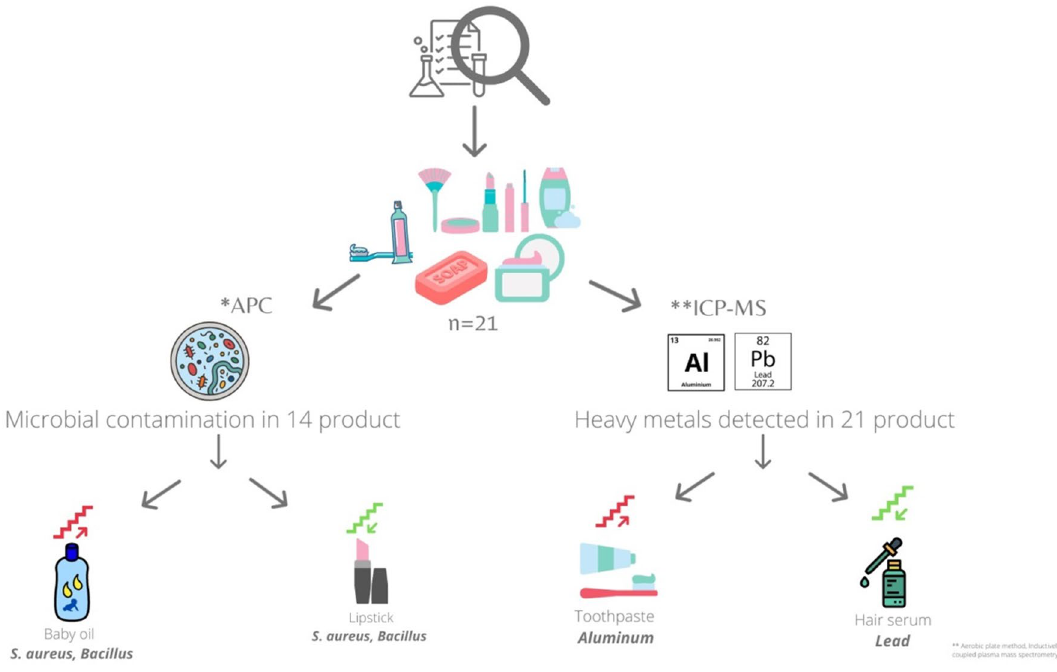
Figure 4. Graphical summary of this